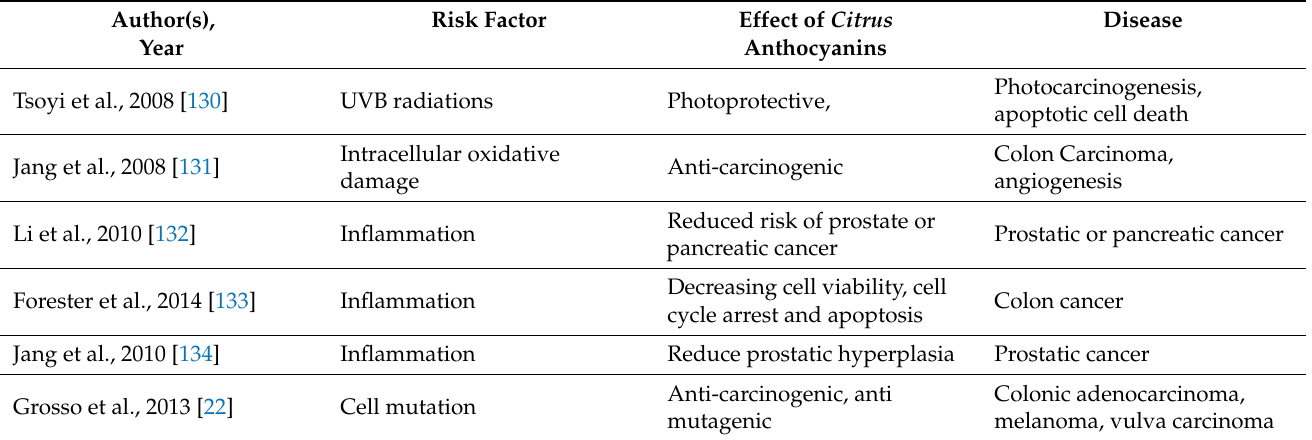
Table 4. Citrus anthocyanins and their anticancer